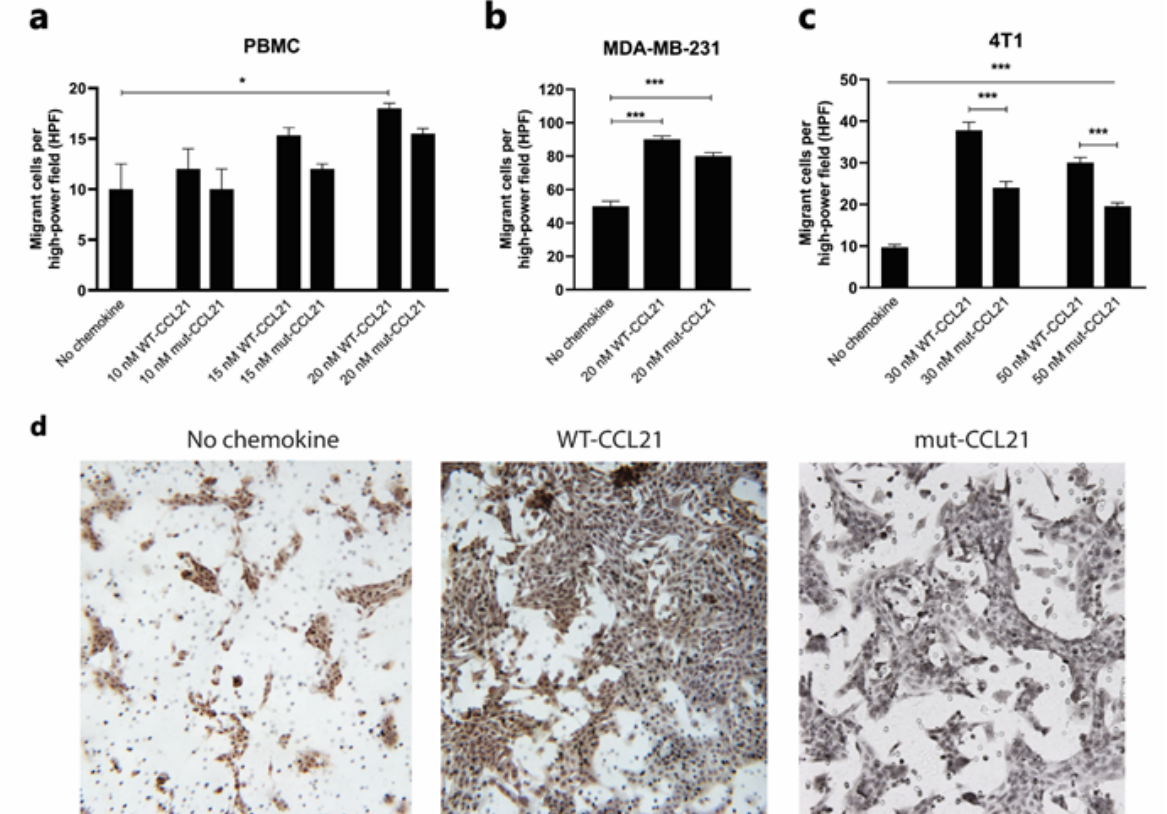
Figure 5. Trans-filter chemotaxis. Trans-filter chemotactic migration of PBMCs ( a ), MDA-MB-231 cells ( b ) and 4T1 cells ( c ) towards several concentrations of WT or mut-CCL21 after optimised incubation time. Graphs show the number of migrated cells adhered to the filter per high power field. Data represent the mean ± SEM of three independent experiments and statistical significance was calculated using one-way ANOVA with Tukey’s multiple comparison test. ( d ) Representative images of migrant 4T1 cells on the underside of chemotaxis filters. Migrant cells were counted using high power microscopy ( × 400) in four random fields on each filter. ***, p < 0.001; *, p <